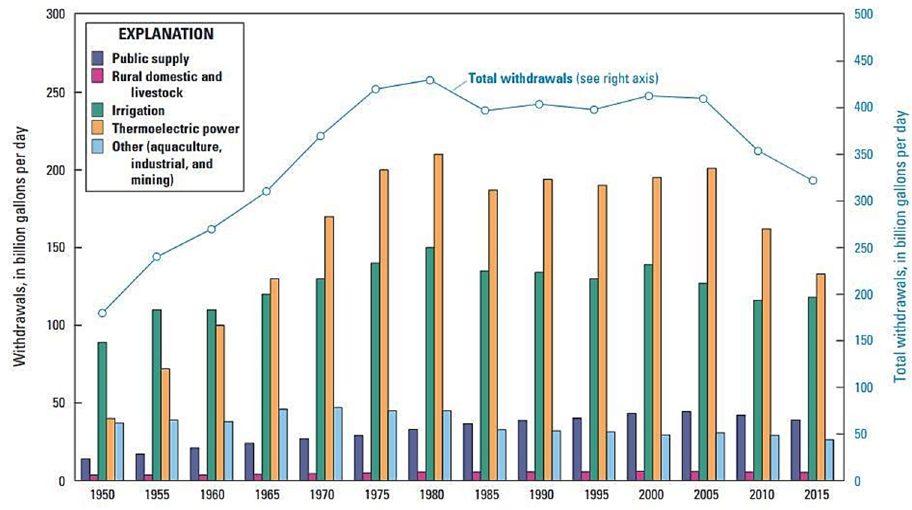
Figure 1. Trends in total water withdrawals by water-use category, 1950–2015 [19].